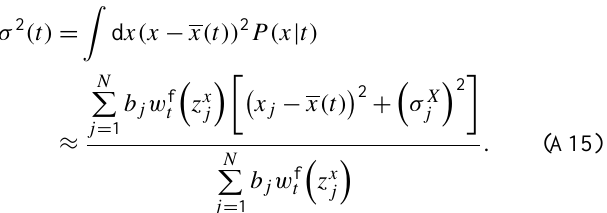
Table B1. 14 C age–depth data from the Lonar lake, central